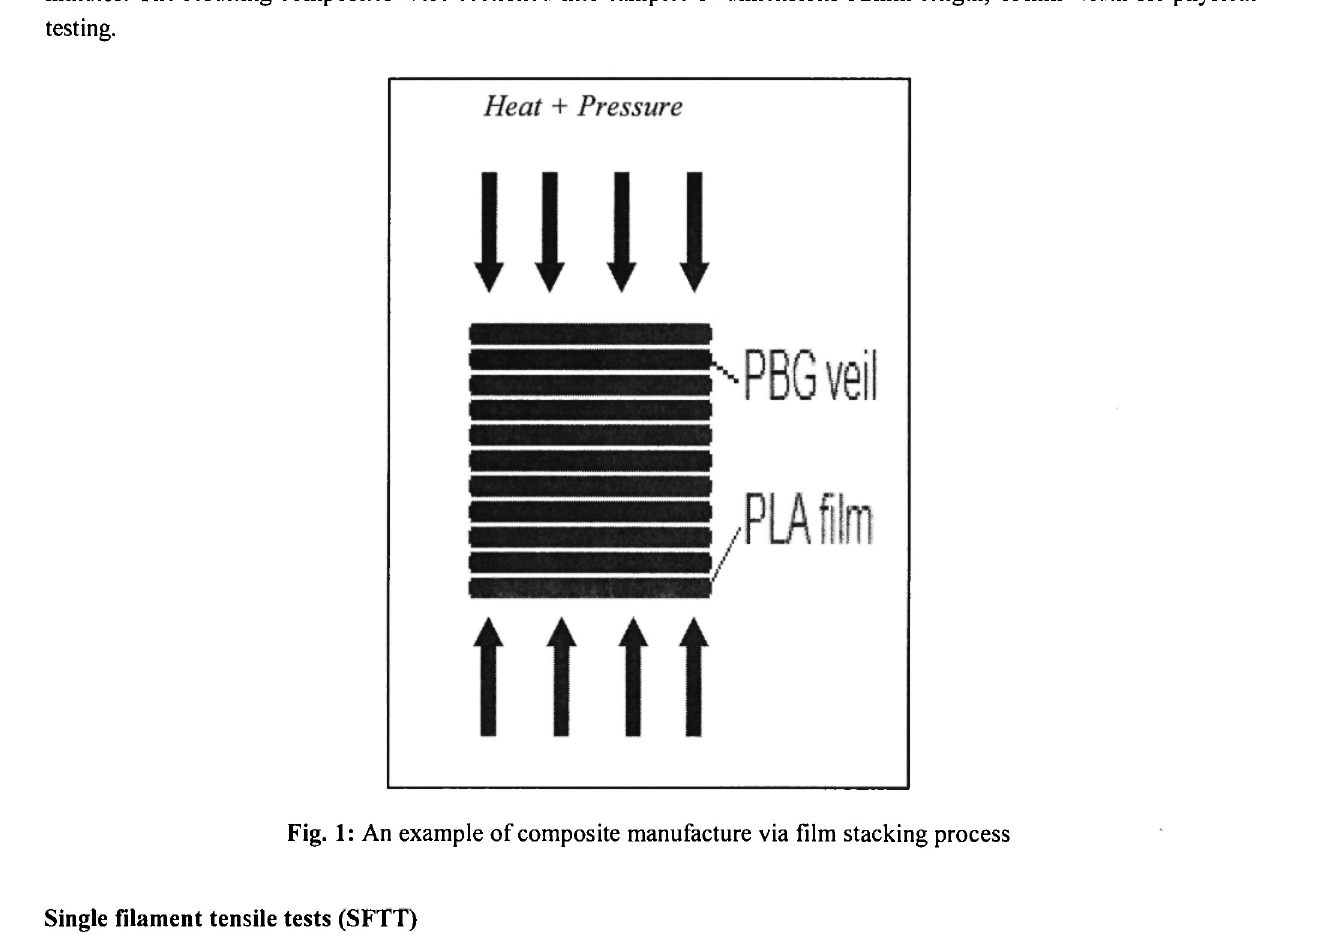
Fig. 1: An example of composite manufacture via film stacking